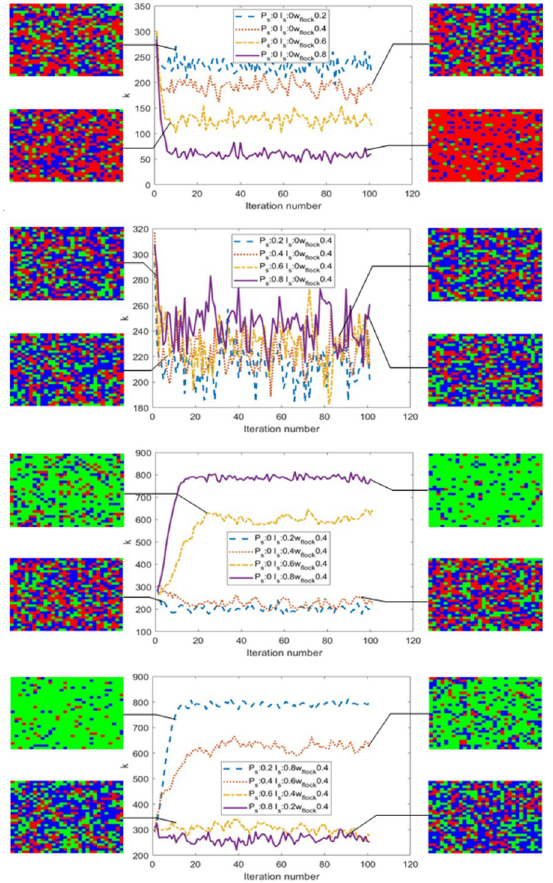
Fig 2. The results of project owner behavior based on cellular automata